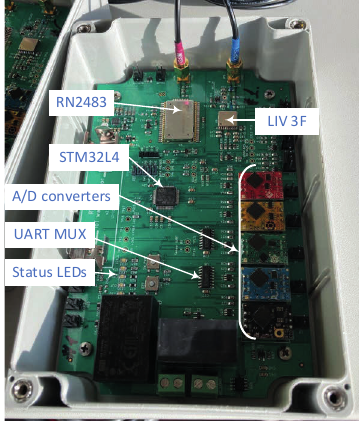
Fig. 2. The PCB of the experimental